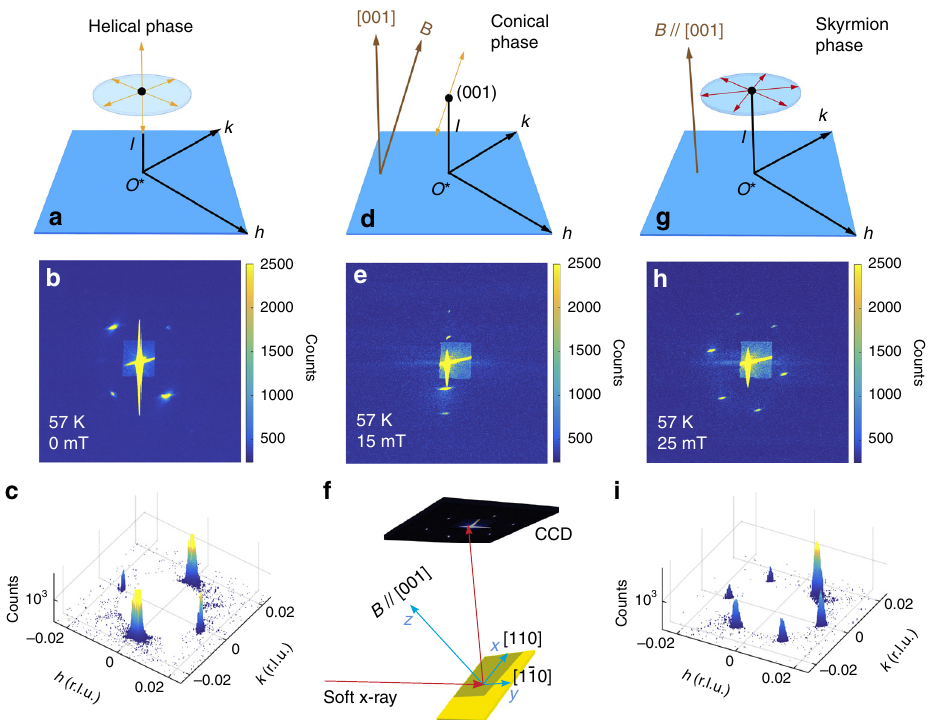
Fig. 2 REXS results for the different magnetic phases of Cu 2 OSeO 3 in the uniform magnetic fi eld setup. The magnetically ordered wavevectors appear as satellites of the structural (0 0 1) peak in reciprocal space. a , b The helical phase is characterised by six wavevectors (shown in orange), of which four can be seen in the time-integrated CCD camera images (at 57 K, 0 mT). c The reciprocal space plot of the ( hk 1)-plane shows two sets of helical magnetic peaks. d , e For the conical state (at 57 K, 15 mT), the magnetic fi eld has to be tilted to − 17° in order to make the magnetic satellites visible. g – i The skyrmion lattice state (at 57 K, 25 mT) is characterised by six peaks. It is obtained by fi eld-cooling from 65 to 57 K. The experimental setup and the scattering geometry are shown in